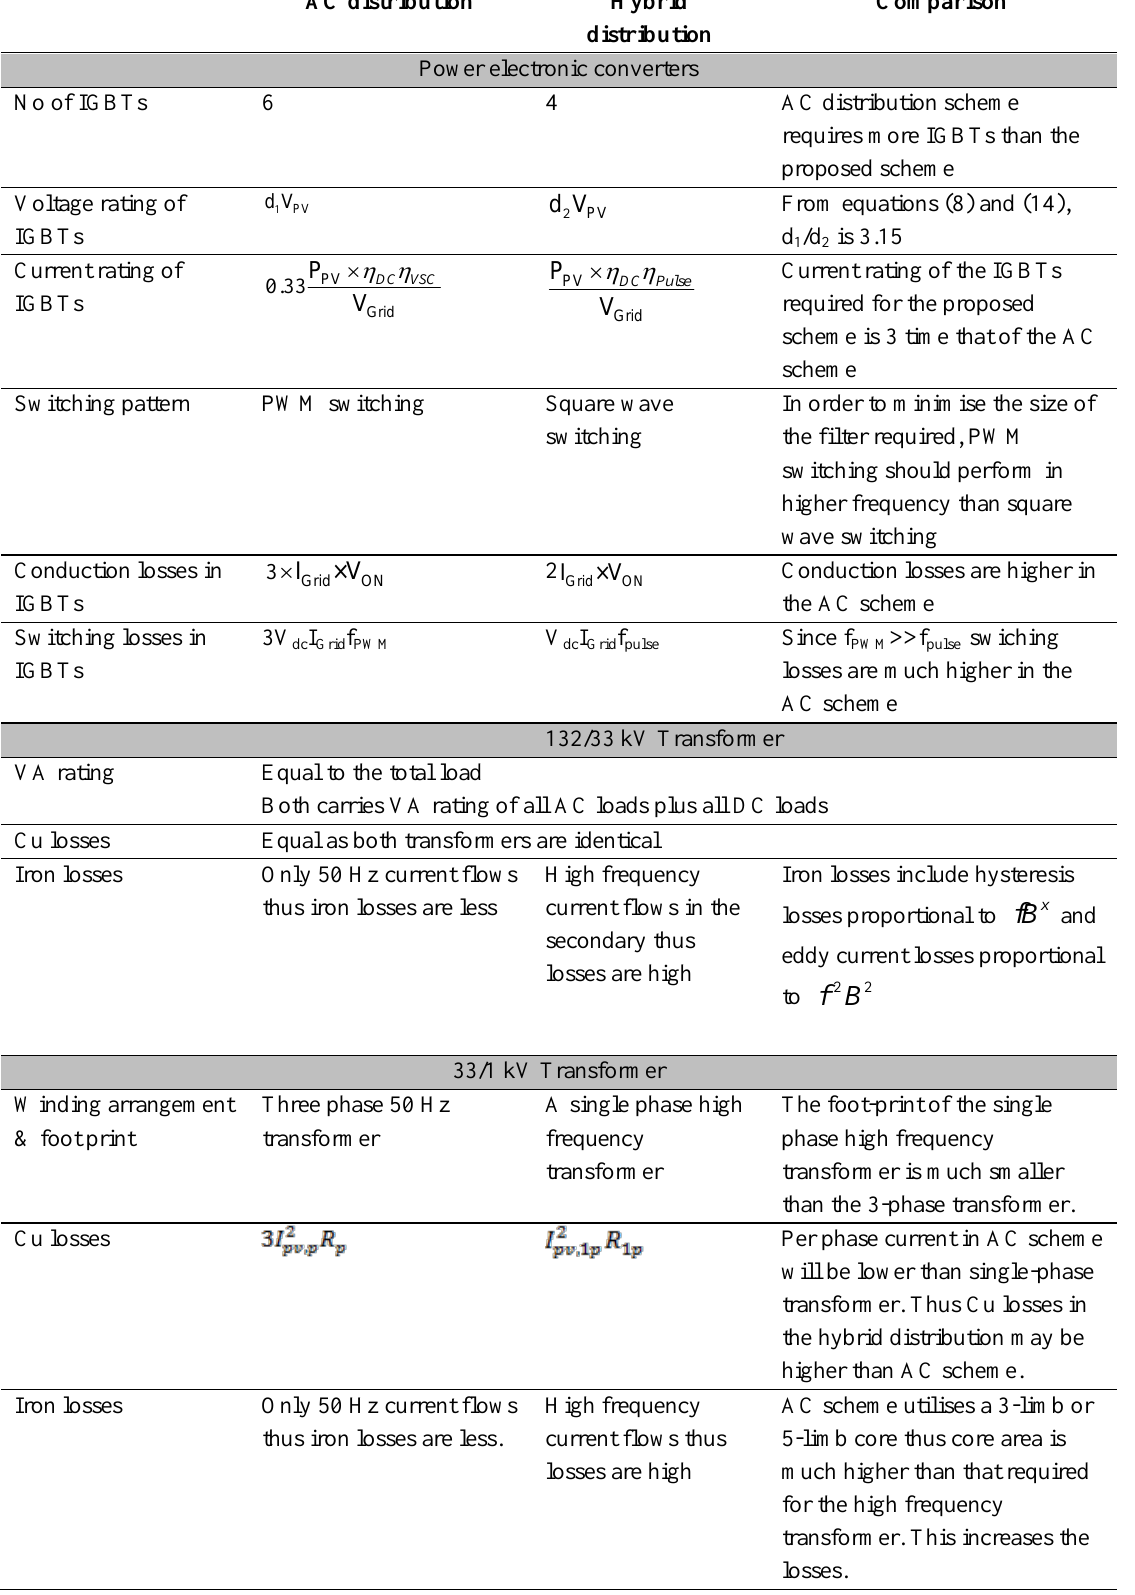
Table 1: Comparison of the AC and hybrid distribution of